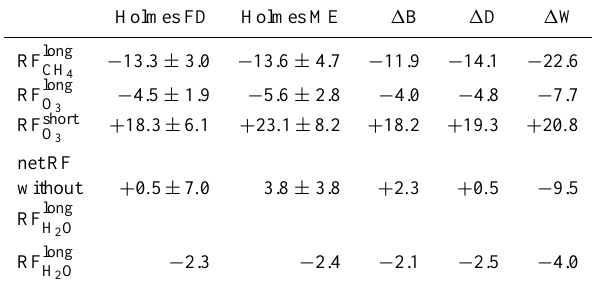
Fig. C1. Monthly mean radiative forcing terms according to Eqs. (11) (Dietm¨uller, 2011), (16), (17) (Ramaswamy et al., 2001), and (19) (Myhre et al., 2007). Note that RF long flect the almost instantaneous response of [OH] to the [NO x ] and [O 3 ] perturbations here, but the actual radiative forcing would rather be determined by the long-term methane response and the seasonal variation of methane mixing ratios. RF short time, but aircraft NO x emissions are not immediately reflected by an ozone perturbation. The error bars are discussed in Appendix C and in Sect. 5.